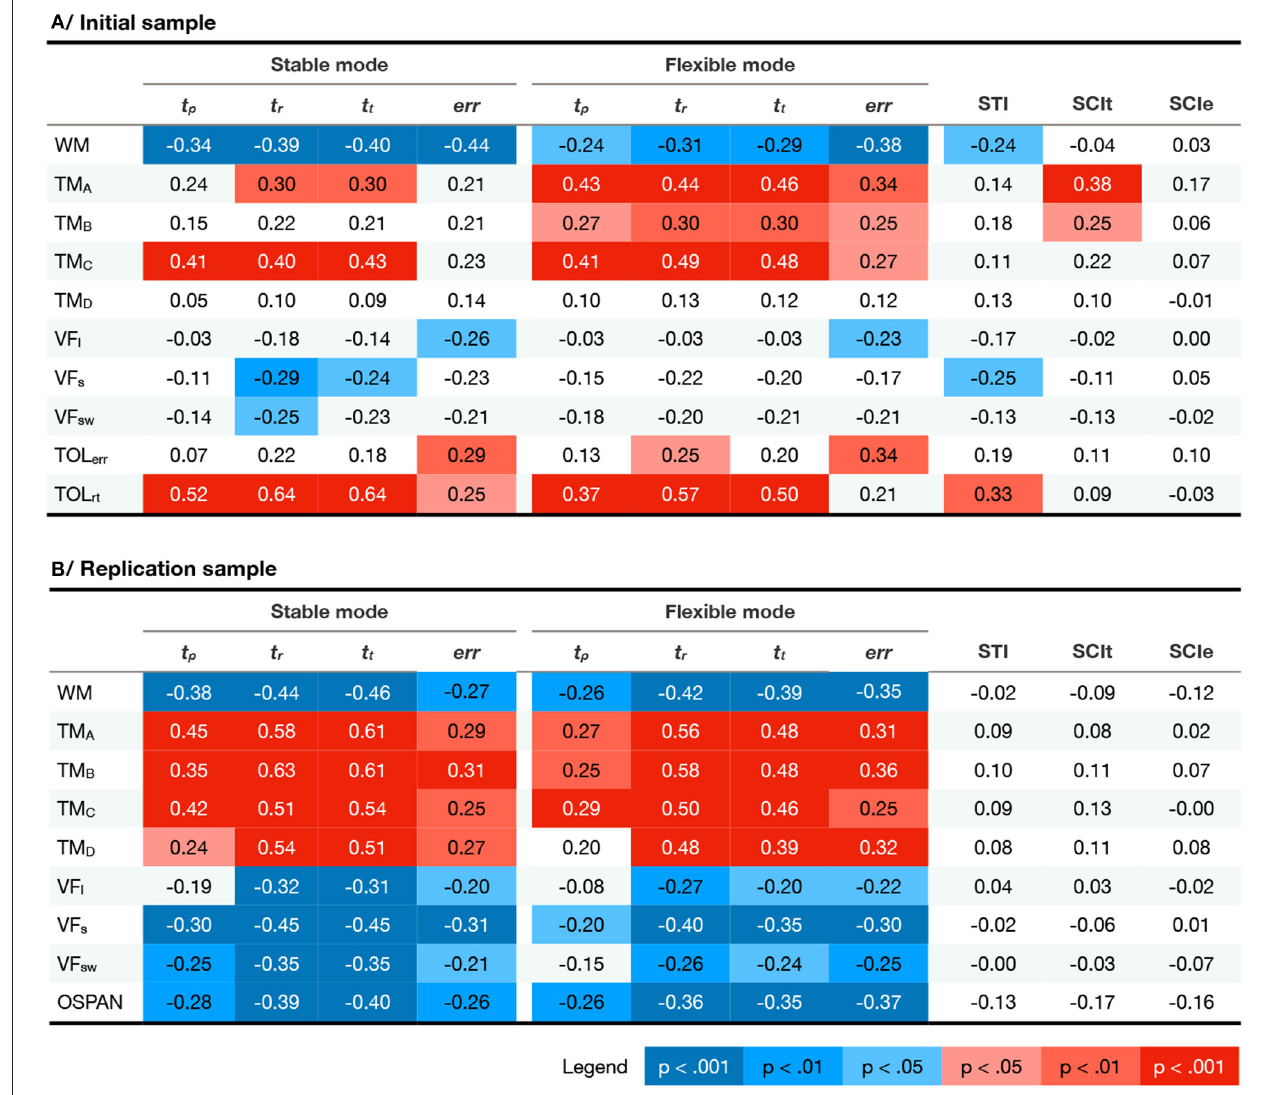
FIGURE 9 | Correlations between C3T measures and standard tests of cognitive control in the stable and flexible modes for both samples. Legend: t p , preparation time; t r , response time; t t , total time; err , error rate; STI , Setup Time Idex; SCI t , preparation-time-based Switching Cost Index; SCI e , error-rate-based Switching Cost Index; WM , working memory span; TM A , time to complete Trail Making task part A; TM B , time to complete Trail Making task part B; TM C , time to complete Trail Making task part C; TM D , time to complete Trail Making task part B subtracted by time to complete Trail Making task part A; VF L , lexical verbal fluency; VF S , semantic verbal fluency;